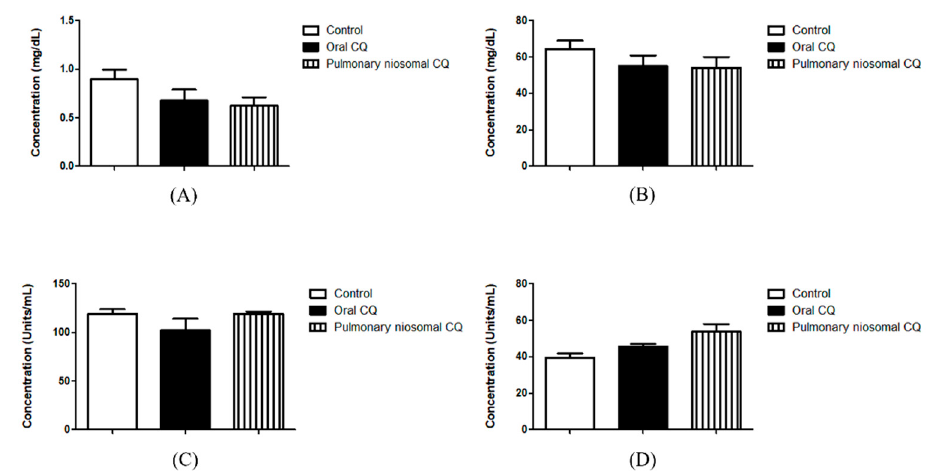
Figure 7. Creatinine ( A ), urea ( B ), AST ( C ), and ALT ( D ) levels in blood of the treated animals following oral and intratracheal administration of chloroquine (CQ) drug solution and drug-loaded niosomes, respectively.